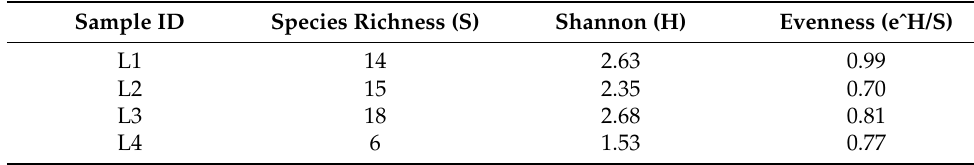
Table 2. Diversity indices for cultivable fungal